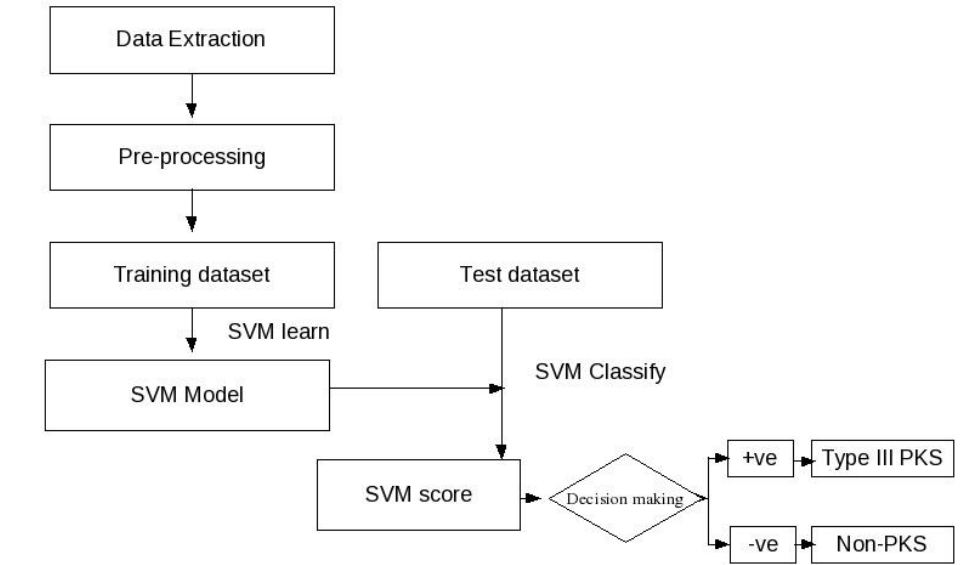
Figure 2: The Architecture of the PKSIIIpred